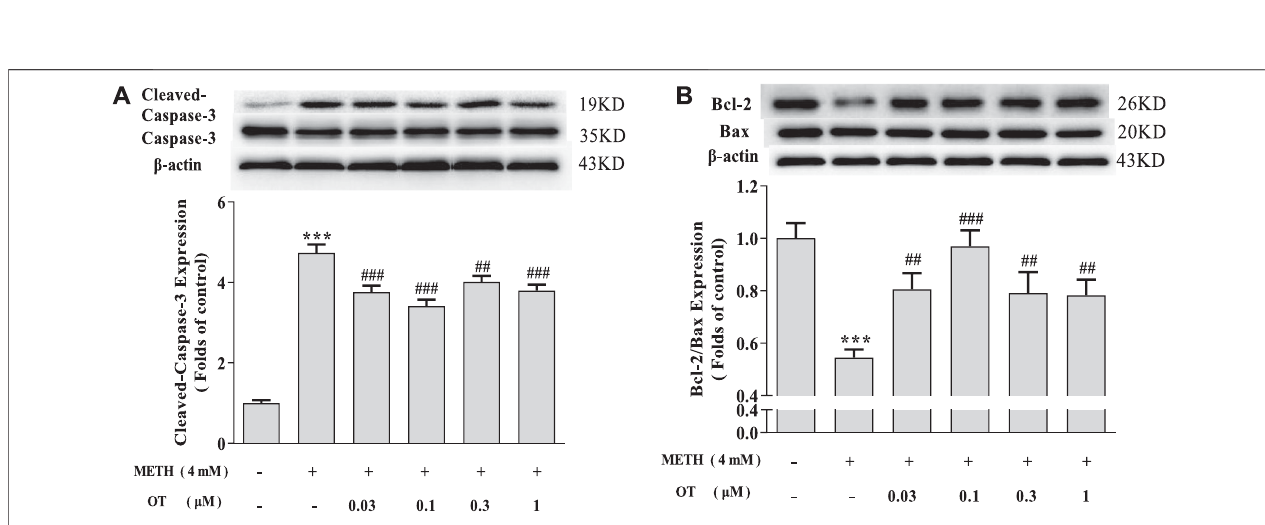
FIGURE 3 | Effects of OT on the expression of apoptosis related proteins changed by METH in hippocampal neurons. (A, B) Hippocampal neurons were pre- treatedwithOT(0.03 – 1 μ M)for2 handstimulatedwithMETH(4 mM)for24 hbywesternblotting.Thedatawereshownasmean ± SEM( n (cid:2) 3).*** p < 0.001compared with control groups; ## p < 0.01, ### p < 0.001 compared with METH